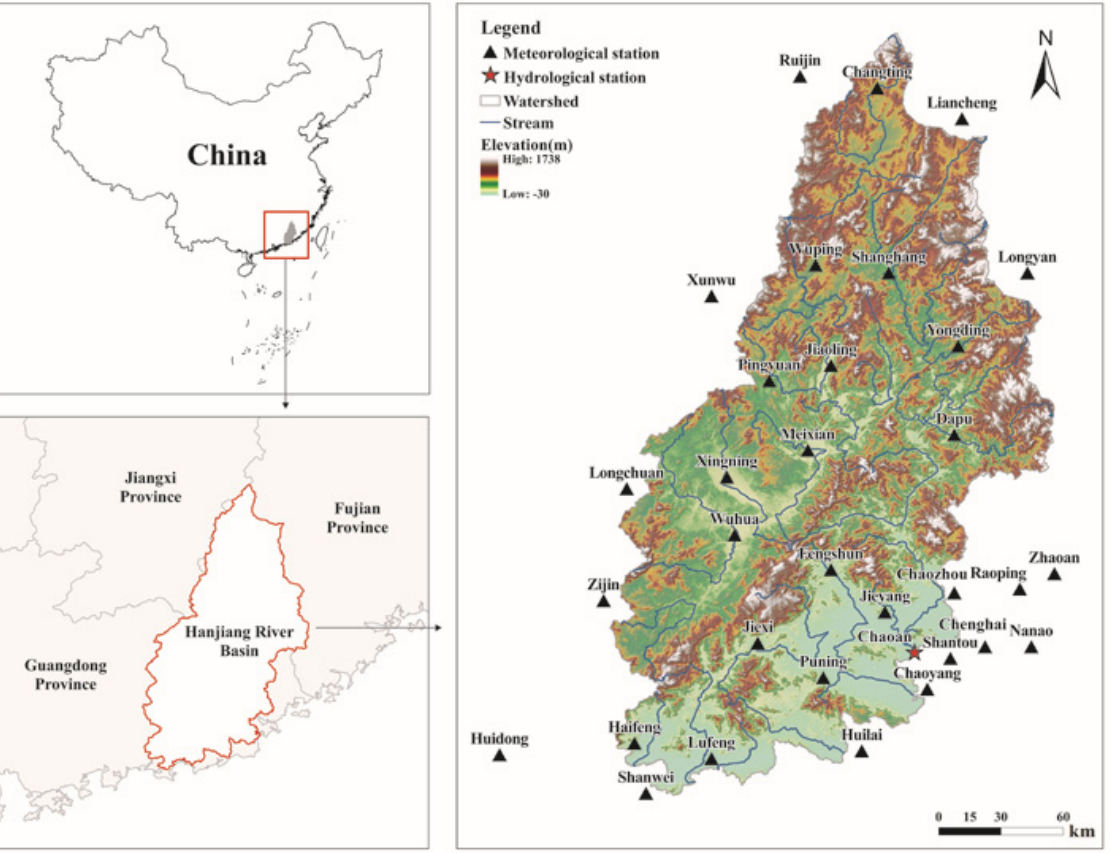
Figure 1. The location and distribution of meteorological and hydrological stations of the Hanjiang watershed.